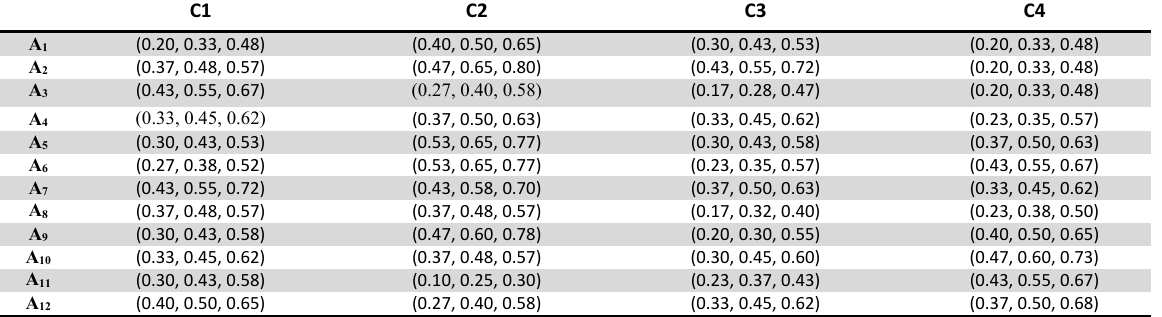
Decision matrix for the proposed fuzzy